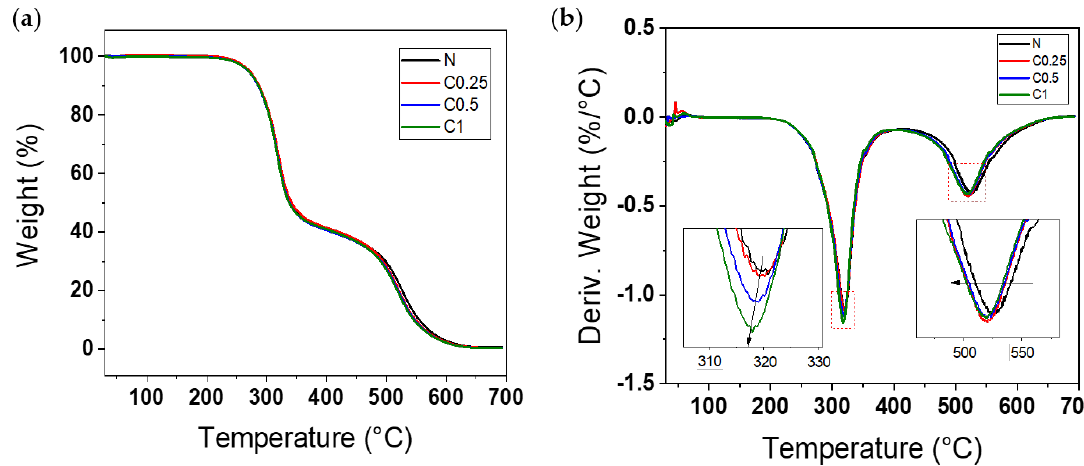
Figure 8. ( a ) TGA, and ( b ) DTG curves of PU foams in air atmosphere.